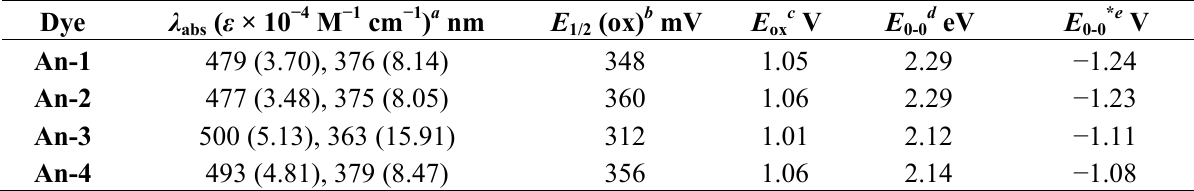
Table 1. Electrooptical and electrochemical parameters of the dyes.